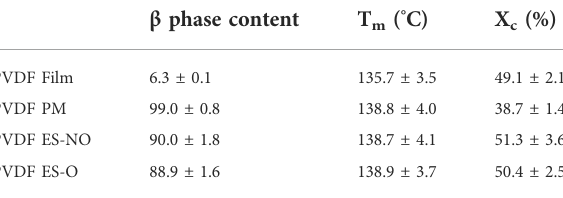
TABLE 1 β -Phase content, melting temperature and degree of crystallinity ofthe produced PVDF samples,as obtained fromFTIR and DSC respectively.